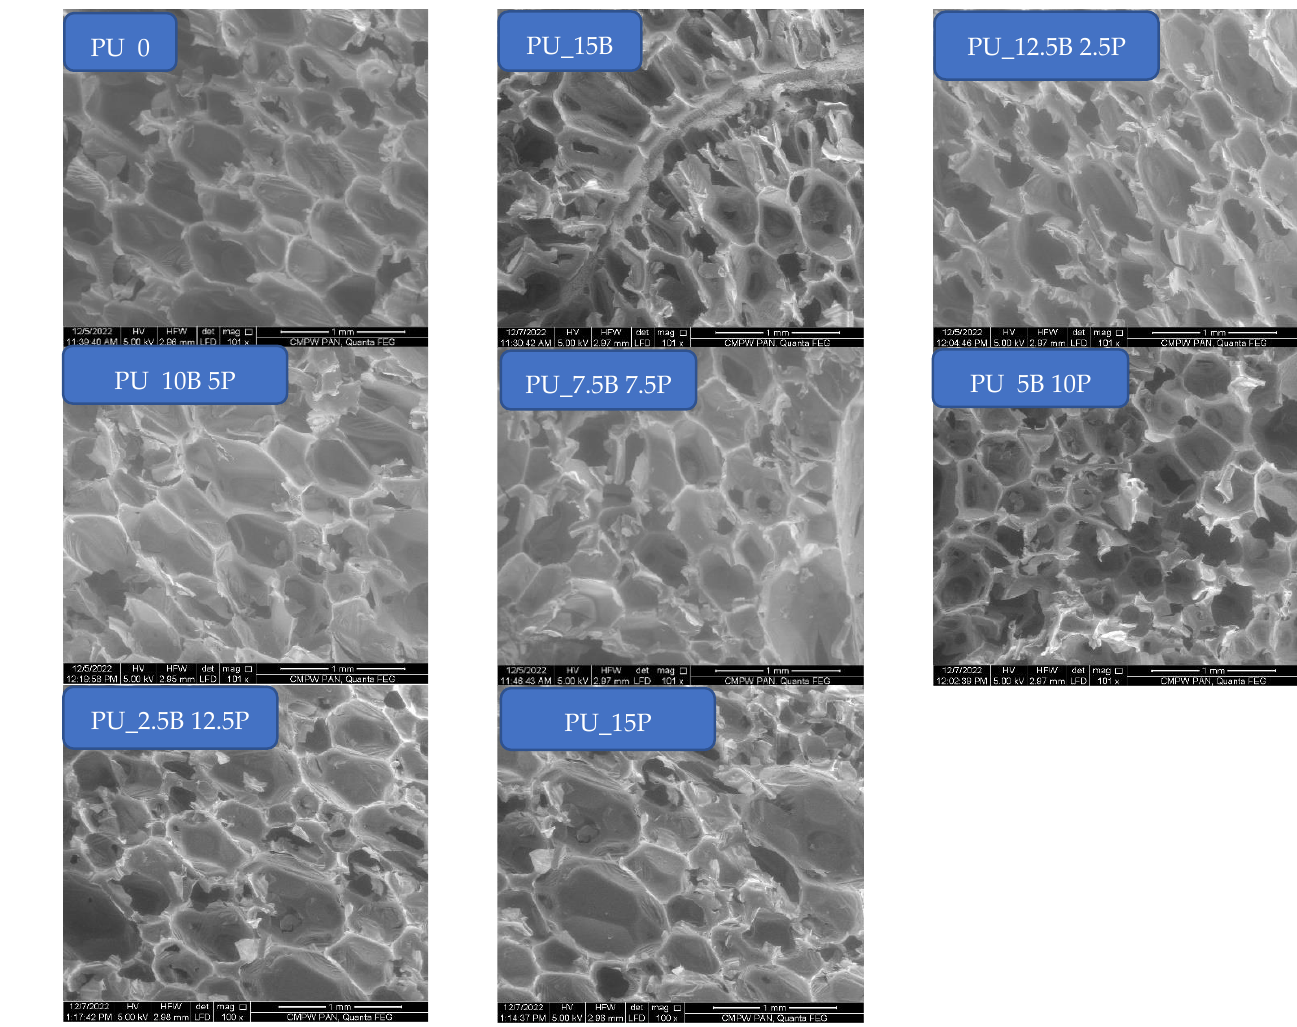
Figure 2. SEM images of rigid PU foams containing buckwheat hulls and perlite in different amounts.